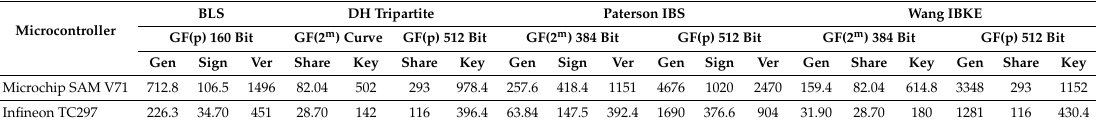
Table 2. Computational overhead in milliseconds on the Microchip SAM V71 and Infineon TC297.